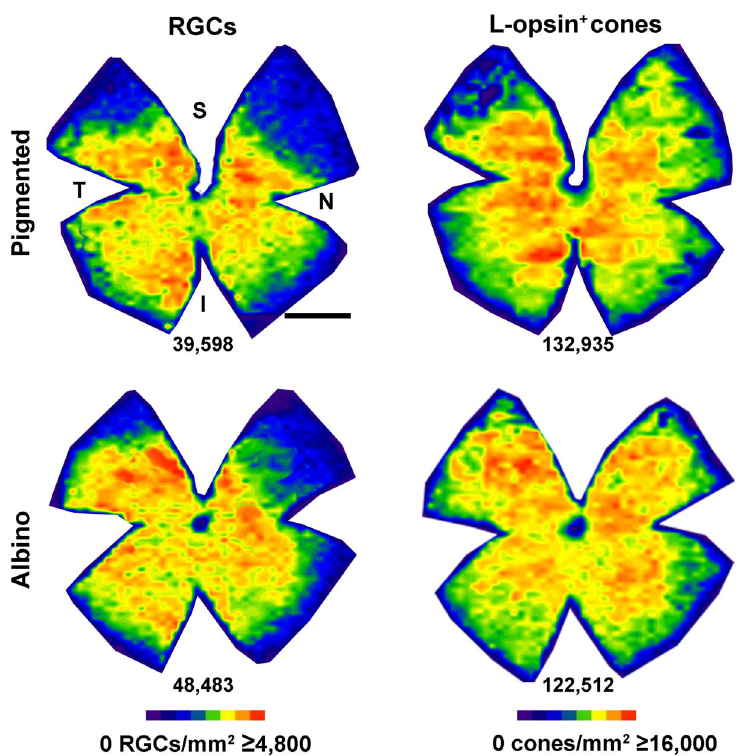
Figure 5. Distribution of RGCs and L-opsin + cones. Isodensity maps showing the distribution RGCs and L-opsin + cones in the same retina of a pigmented (first row) and an albino (second row) mouse. Below each map is shown the number of cells quantified in its corresponding retina. Colour scale density code is at the bottom of the figure. S: superior, N: nasal, I: inferior, T: temporal. Bar: 1 mm.